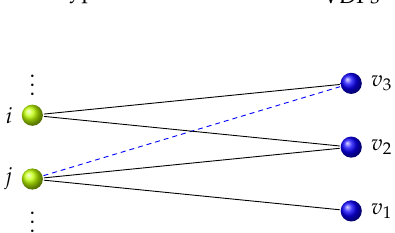
Figure 8. Preferential attachment network: a second way to define a focused cross-reactivity network. If two clonotypes share a VDP, we hypothesized that their TCR structures might be similar, and thus, that they might share other VDPs as well (with a greater probability than by chance). Clonotypes i and j both recognize v 2 and clonotype i recognizes v 3 . Hence, we sampled from the set of VDPs recognized by clonotype i (and not in the set of VDPs recognized by clonotype j ). In this case this set was v 3 , so we sampled again to decide whether j can also recognize v 3 .